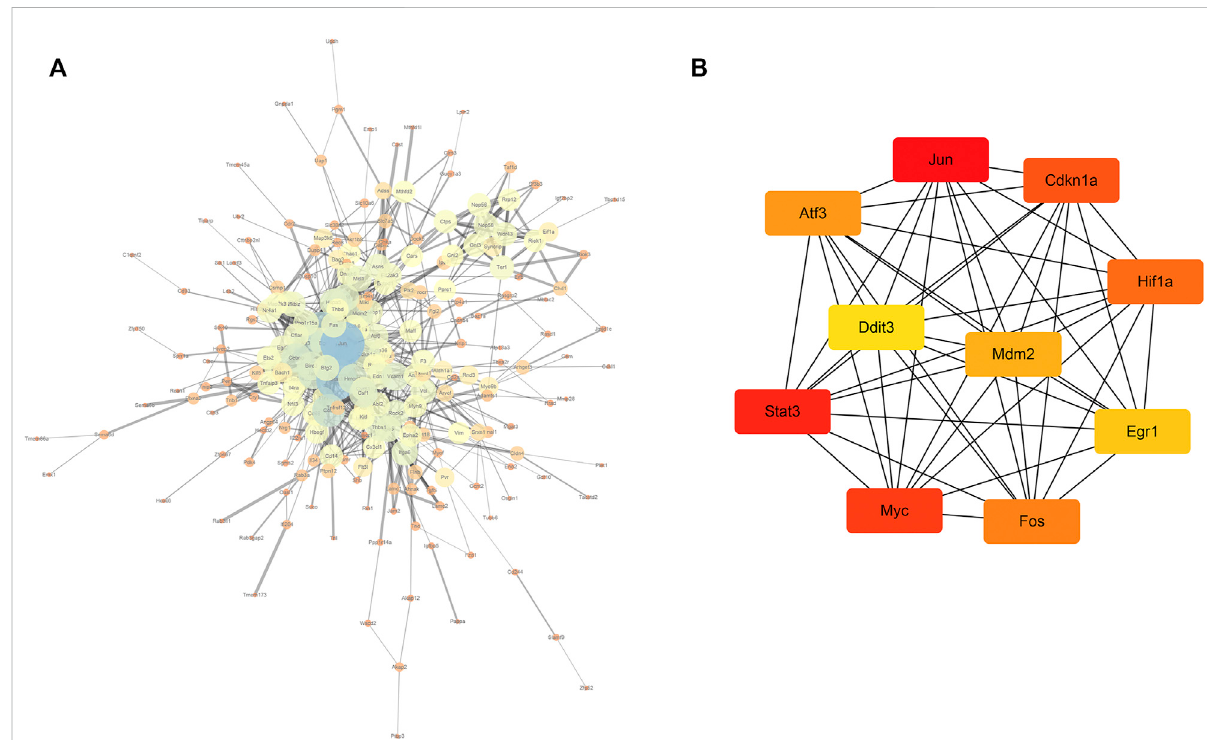
FIGURE 7 PPI network and core gene screening (A) using the NetworkAnalyzer plug-in to modify the PPI network; the larger the node, the greater the degreeofconnectivity(degree),andthethickertheline,thegreaterthecombined_scorevalue; (B) top10coregeneinteractionnetworks;thedarker the color, the more powerful the critical degree.